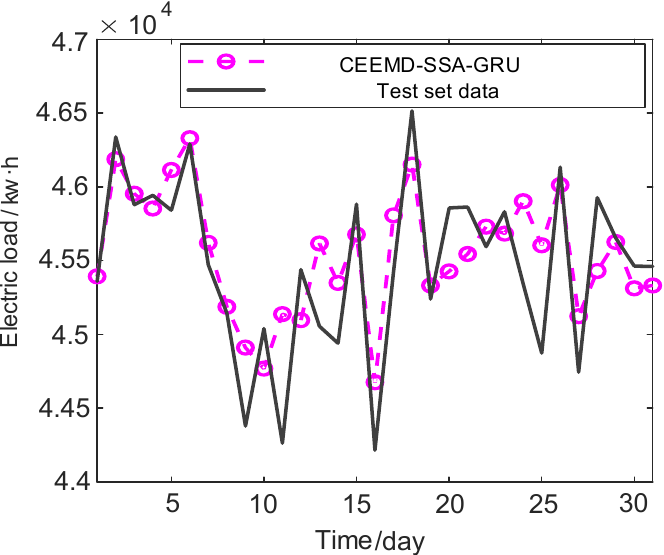
Figure 14. CEEMD–SSA–GRU model prediction data.